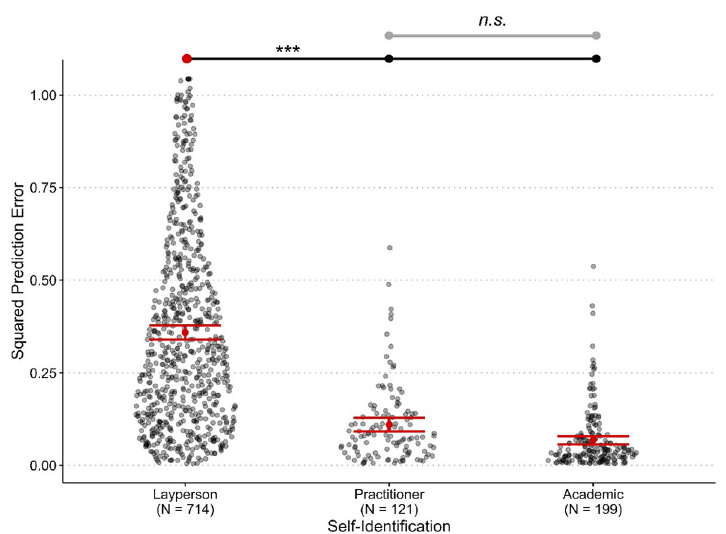
Figure 4. Prediction error by self-identified group. Note : Variables ordered by largest to smallest prediction error (left to right). Black and transparent dots indicate the distribution of individual data points for prediction error across categories. Black dots above the distribution of data points represent categories that show statistically significant differences, whereas red dots above the distribution of data points represent reference categories for comparing statistically significant differences between more than two categories. Gray dots and a gray line indicate a non-significant (n.s.) relationship. Error bars are the 95% confidence interval of the mean. ***p <